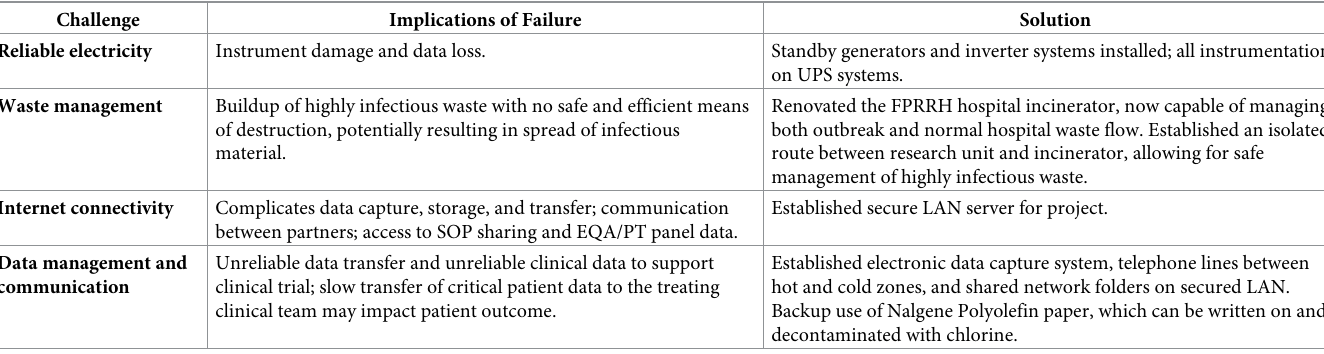
Table 1. Core capability